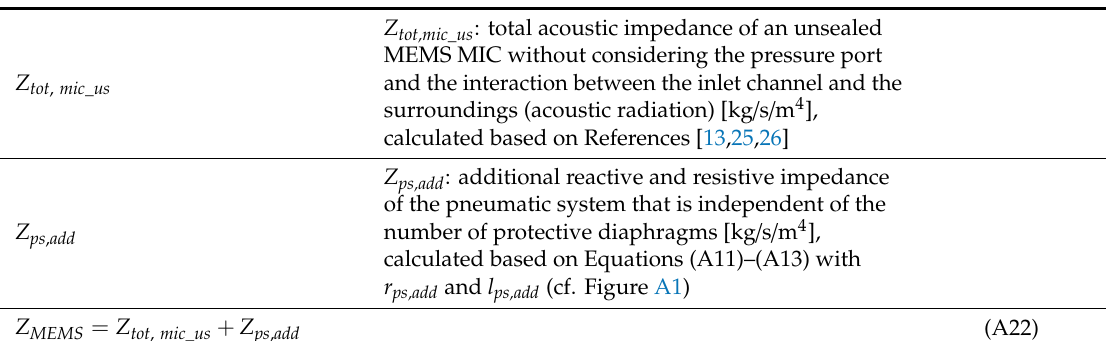
Table A5. Lumped parameter model for the acoustic impedance of the MEMS microphone